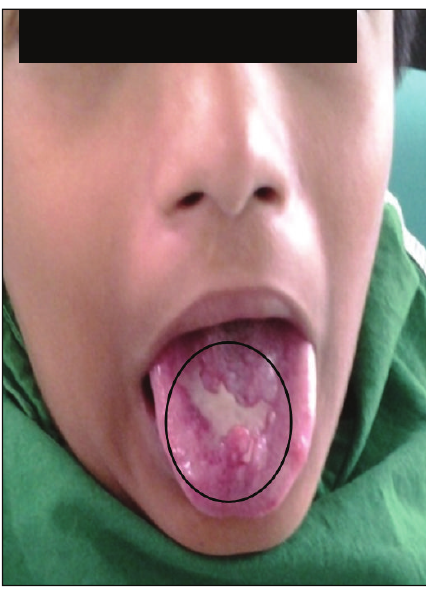
Figure 7: Posttreatment photograph showing complete healing of